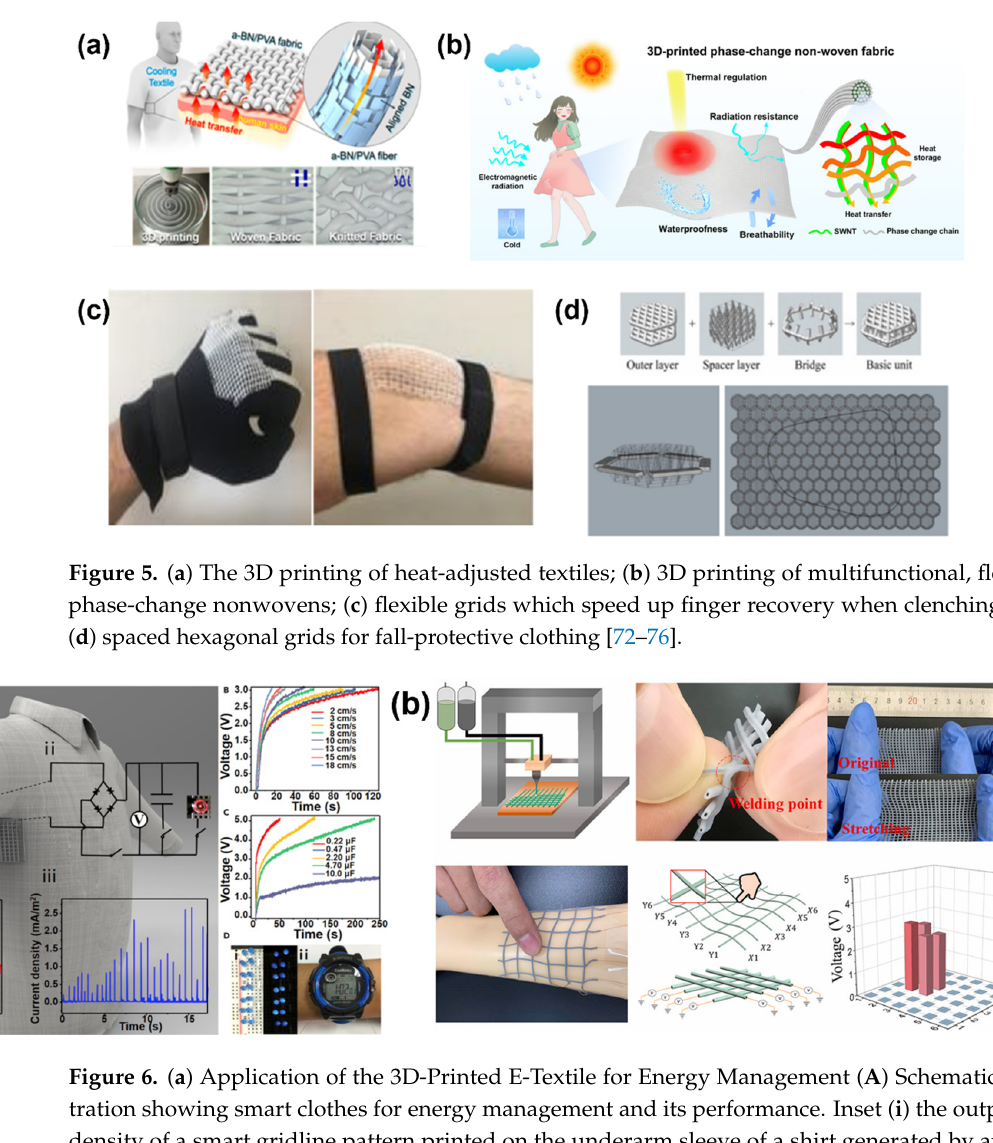
Figure 6. ( a ) Application of the 3D-Printed E-Textile for Energy Management ( A ) Schematic illus- tration showing smart clothes for energy management and its performance. Inset ( i ) the output I sc density of a smart gridline pattern printed on the underarm sleeve of a shirt generated by an arm